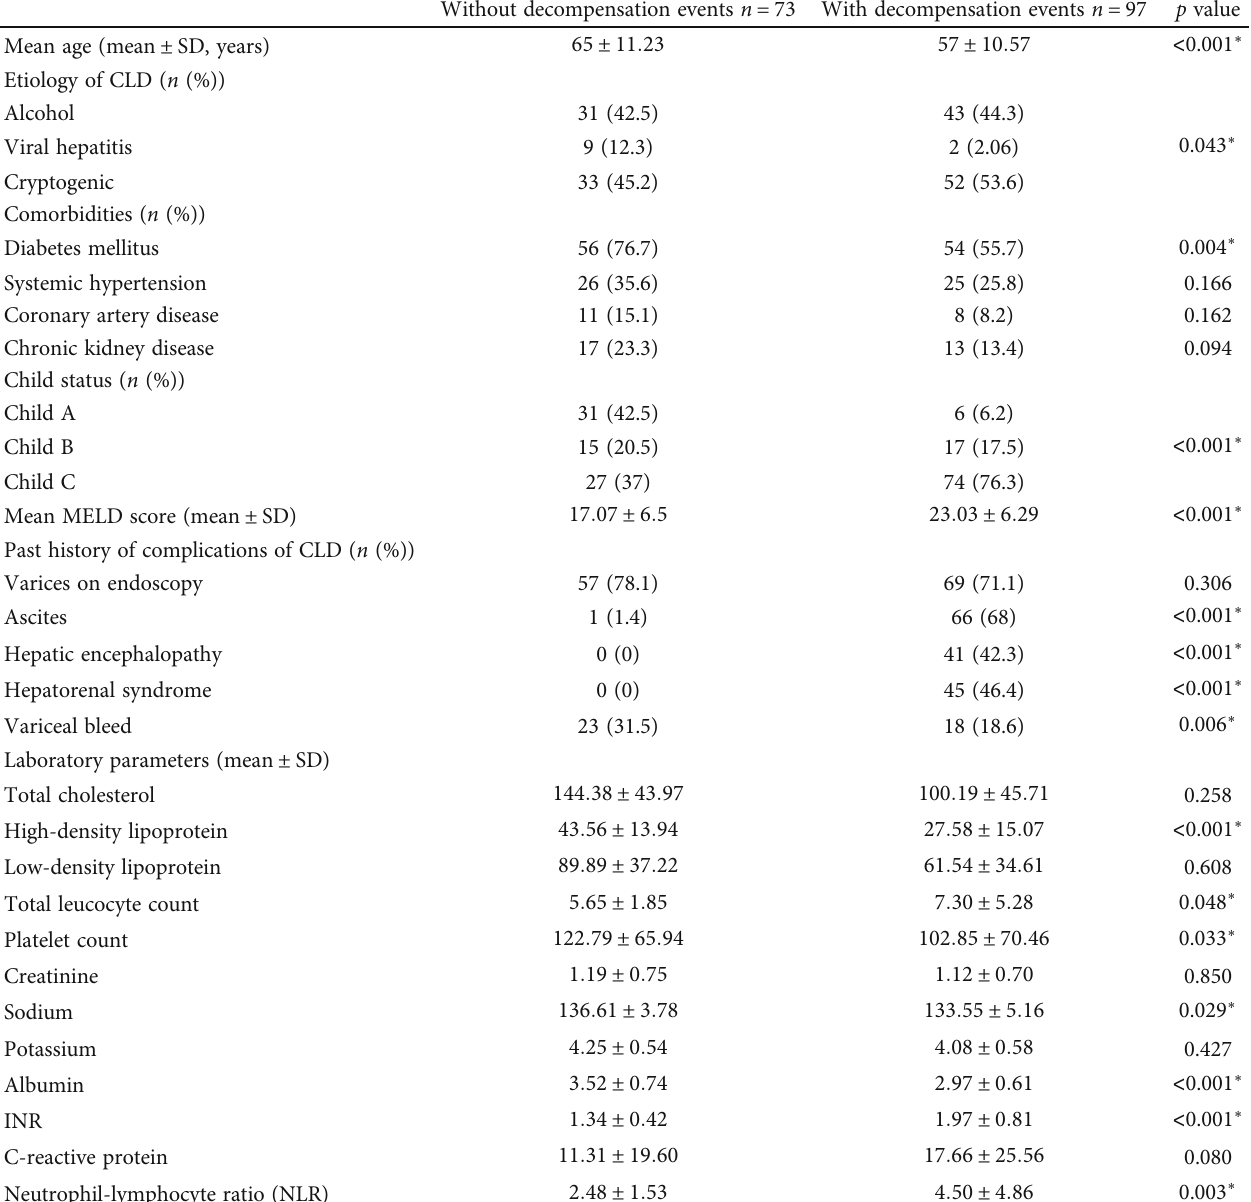
Table 2: Factors associated with risk of decompensation on follow-up in patients with cirrhosis of liver. Without decompensation events n = 73 With decompensation events n =